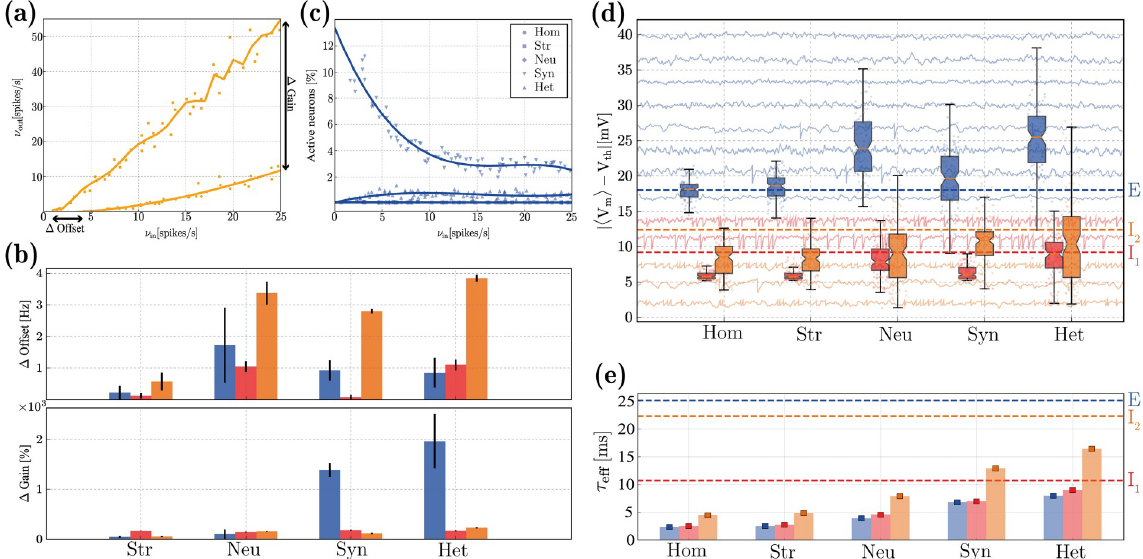
Fig 4. Characteristics of population activity in the quiet state. ( a ): Rate transfer function of the I 2 neurons in the homogeneous (dots) and structurally heterogeneous (squares) conditions. ( b ): Change in absolute gain ( Δ Gain, expressed as a percentage of rate gain relative to the baseline homogeneous condition) and offset ( Δ Offset), see annotations in (a), for the E (blue), I 1 (red) and I 2 (orange) populations, for each heterogeneous condition (structural, neuronal, synaptic, and all forms combined), relative to the homogeneous condition. Error bars indicate the standard deviation across ten simulations per condition. ( c ): Fraction of active E neurons in the different conditions as a function of input rate ν . ( d ): Distributions of absolute distances between neurons’ mean membrane potentials h V m i and their firing threshold V th , for the three in neuronal populations considered, under the different heterogeneity conditions. The dashed lines indicate the corresponding values reported in [94]. For illustrative purposes, we depict V traces for a small set of randomly chosen neurons in the background. ( e ): Effective membrane time m constants ( τ eff = C m / h G total i ) in the noise-driven regime, for the different neuronal classes and conditions. Error bars correspond to the means and standard deviations across each population. The dashed lines indicate the baseline values ( τ 0 = C m /g leak ). All results depicted were calculated over an observation period of 10 s . The results depicted in ( d, e ) were acquired with a fixed input rate of ν = 10 spikes/s and correspond to the in distributions across the population, for a single simulation per condition.